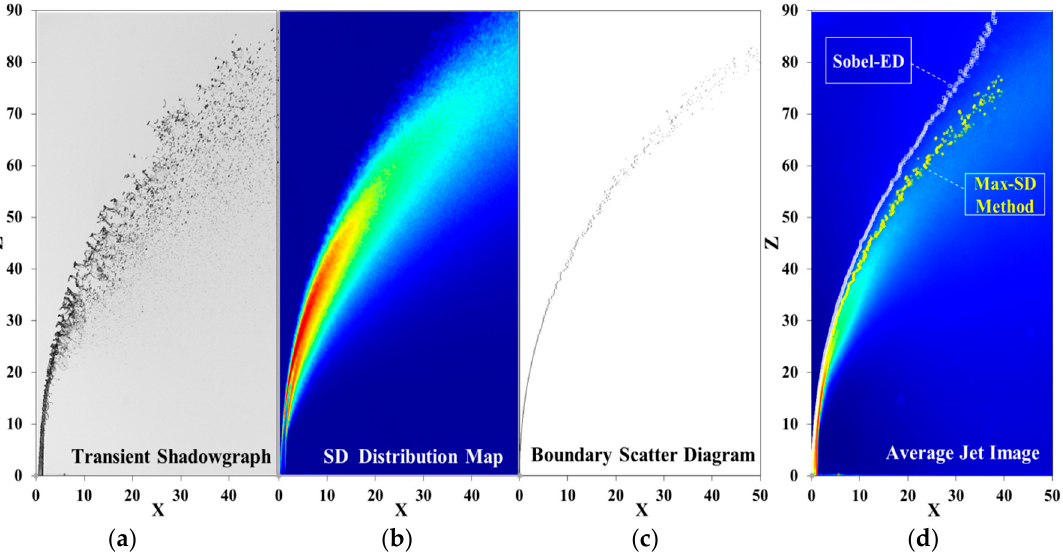
Figure 5. Image processing method for the jet boundary: ( a ) Transient shadowgraph of a transverse jet; ( b ) Grayscale SD distribution map; ( c ) Upwind boundary relevant to Max-SD; ( d ) Comparison with Sobel-ED method.